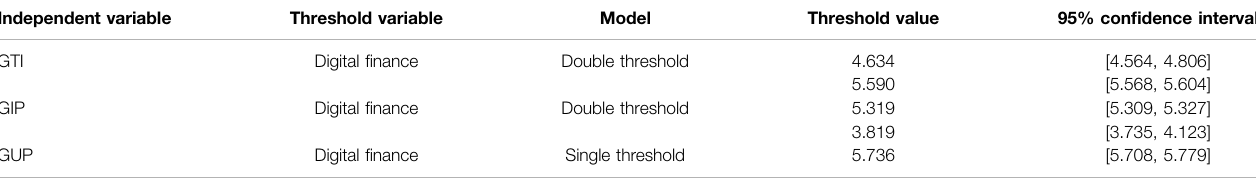
TABLE 9 | Value of threshold estimation and its con fi dence interval.